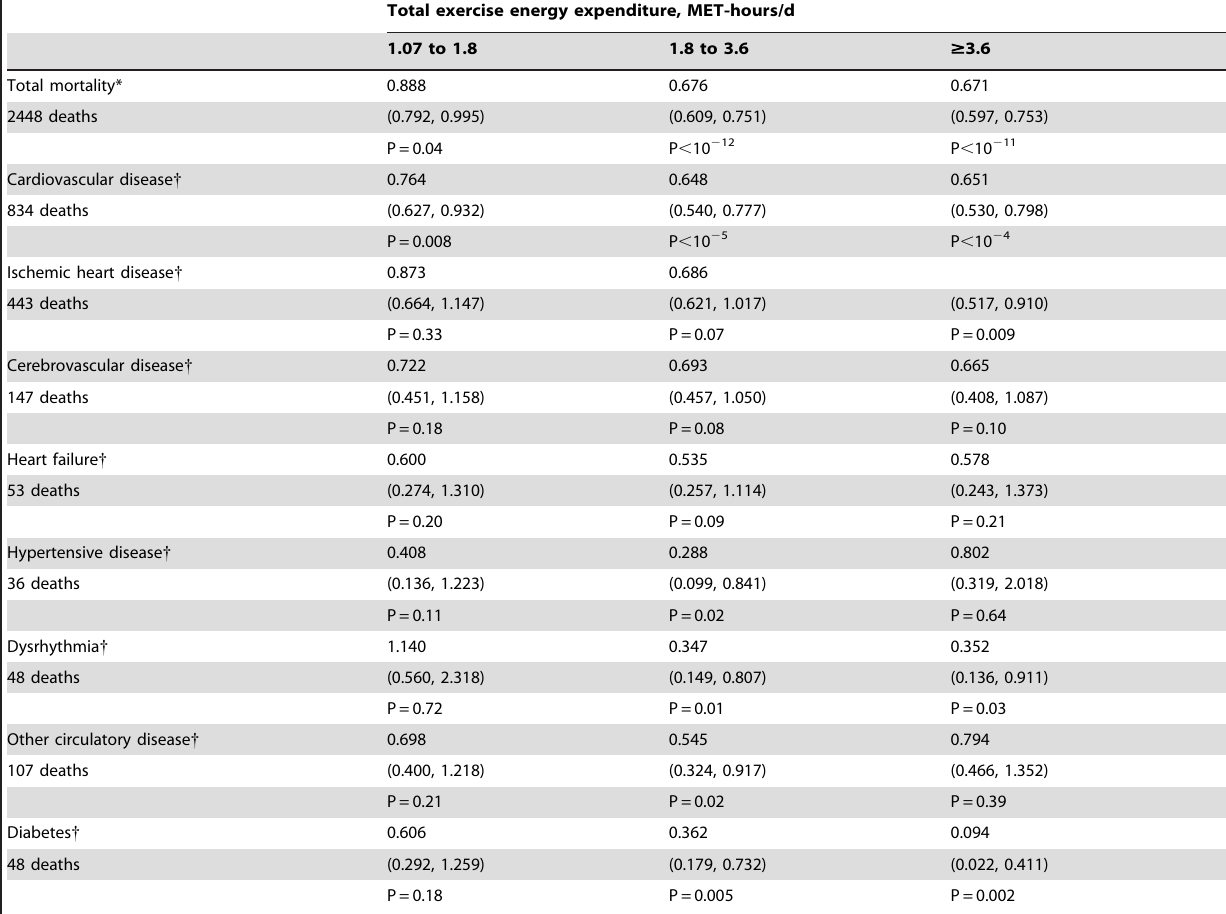
Table 3. Survival analyses of underlying cause of death vs. categories of physical